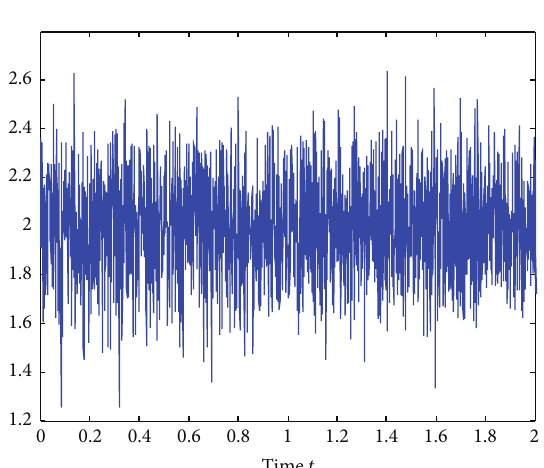
Figure 2: Random coupling strength 𝑐 2 (𝑡) .